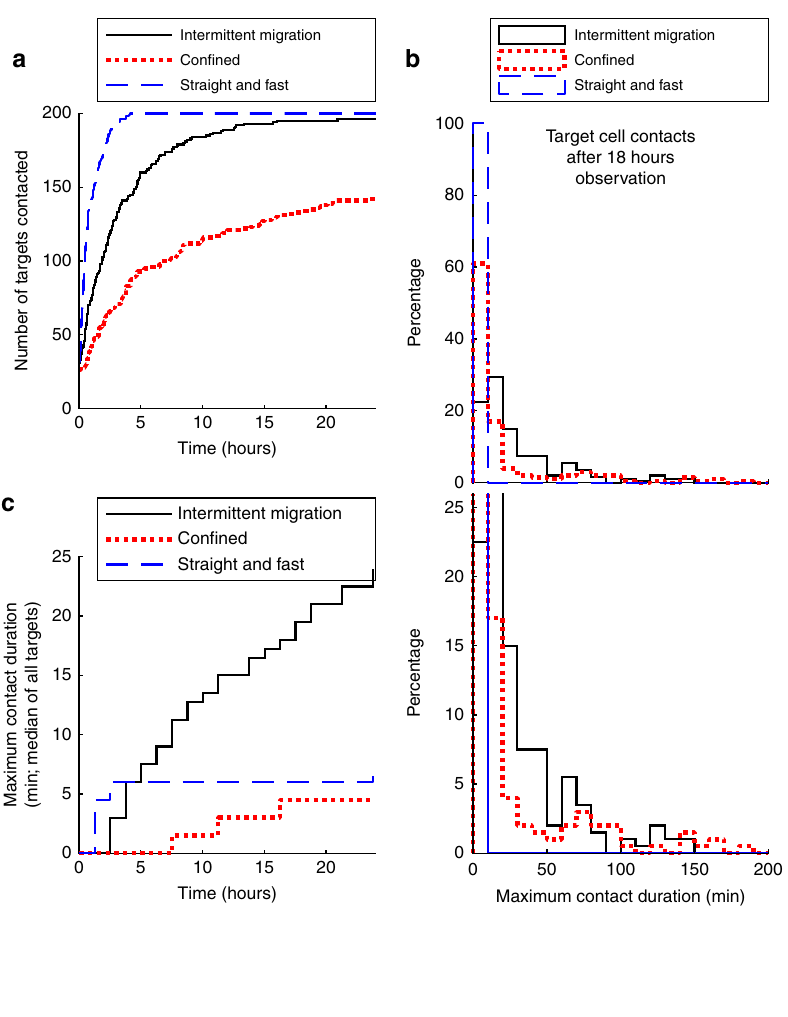
Fig. 8 Intermittent migration increases long-lasting T cell target cell contacts. Contacts between 200 motile T cells and 200 target cells within a 1 mm 2 region were quanti fi ed using a computational model (see Methods). a The number of target cells that were contacted by any of the T cells is shown over time. b Eighteen hours after the initiation of the simulation, for each target cell the longest continuous contact with a T cell was calculated. The percentage of different contact durations is shown for each migration mode. Upper panels and lower panels have a different range on the y -axis, so that the percentage of short ( upper panel ) and long ( lower panel ) contacts can be seen. c The contact duration between T cells and targets was calculated as described in panel b , for various chosen observation periods as indicated on the x -axis. For each datapoint, the median of all contact durations is